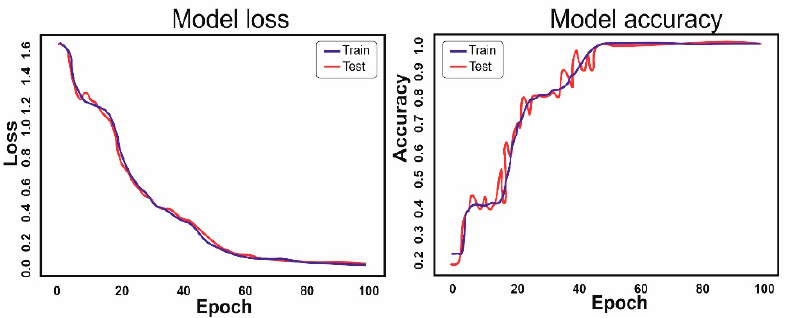
Figure 6. Graphs of the loss function and accuracy of boxers with 1 year of training experience.